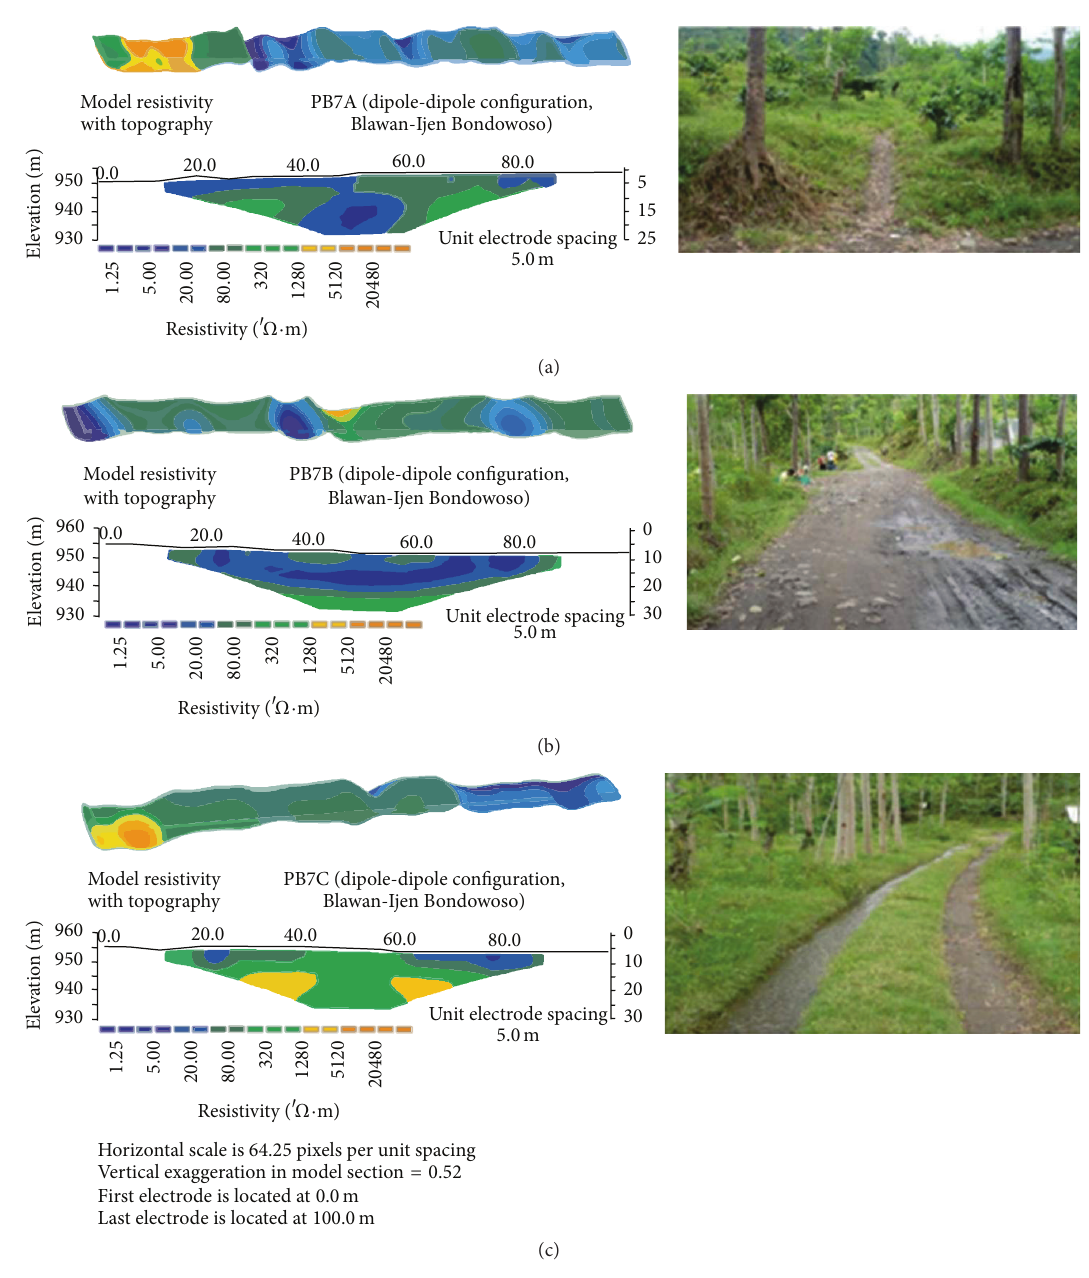
Figure 11: 2D Resistivity Mapping and GPR amplitude slice in locations (a) PB7A, (b) PB7B, and (c) PB7C.